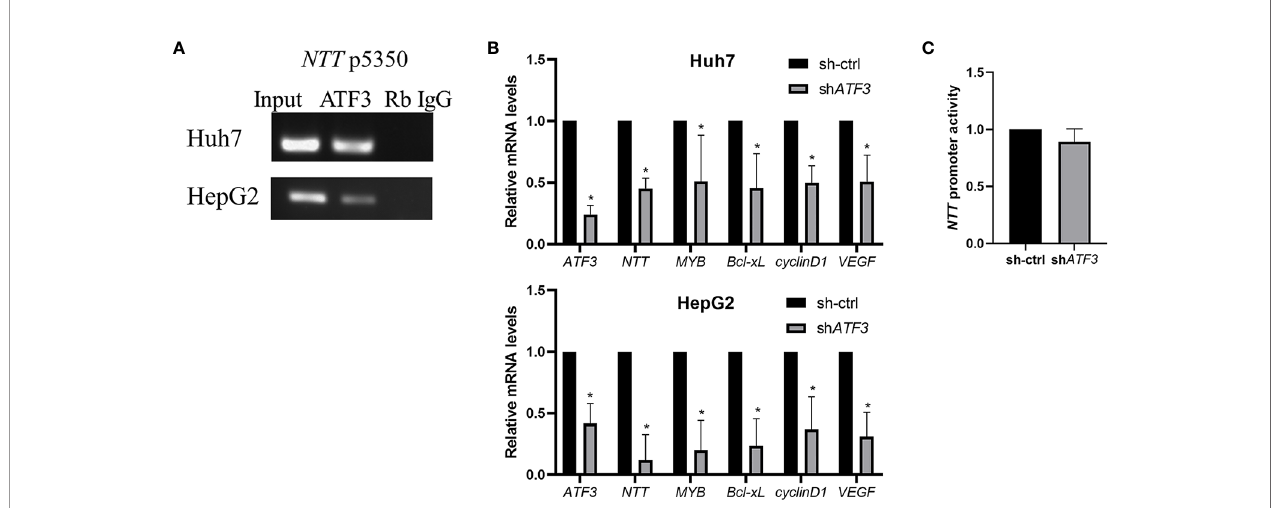
FIGURE 5 | The functional effects of NTT are modulated by ATF3. (A) DNA ChIP-qPCR analysis of ATF3 occupancy of the NTT promoter region, shown by a representative graph of three independent experiments. (B) Knockdown of ATF3 by shRNA resulted in lower expression of NTT and its downstream genes. * p < 0.05. (C) Activity of promoter determined using a luciferase assay upstream of NTT